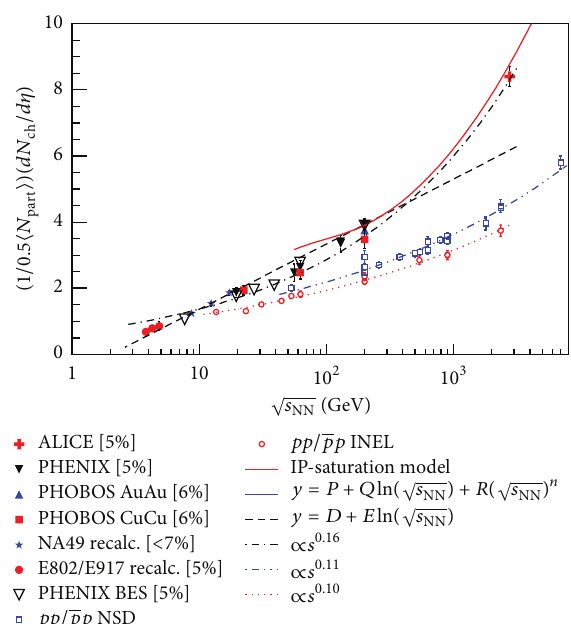
Figure 18: Energy dependence of charged particle multiplicity density distribution per participant pair for most central collisions at midrapidity. Compared are the corresponding measurements in 𝑝 + 𝑝/𝑝 + 𝑝 NSD and INEL collisions.